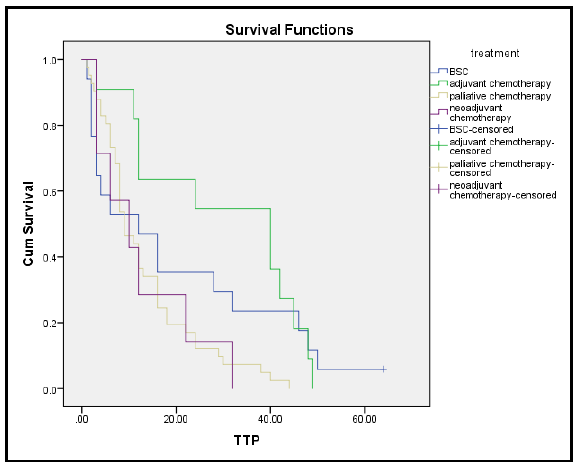
Figure 1: Relation between time to progression and treatment modalities